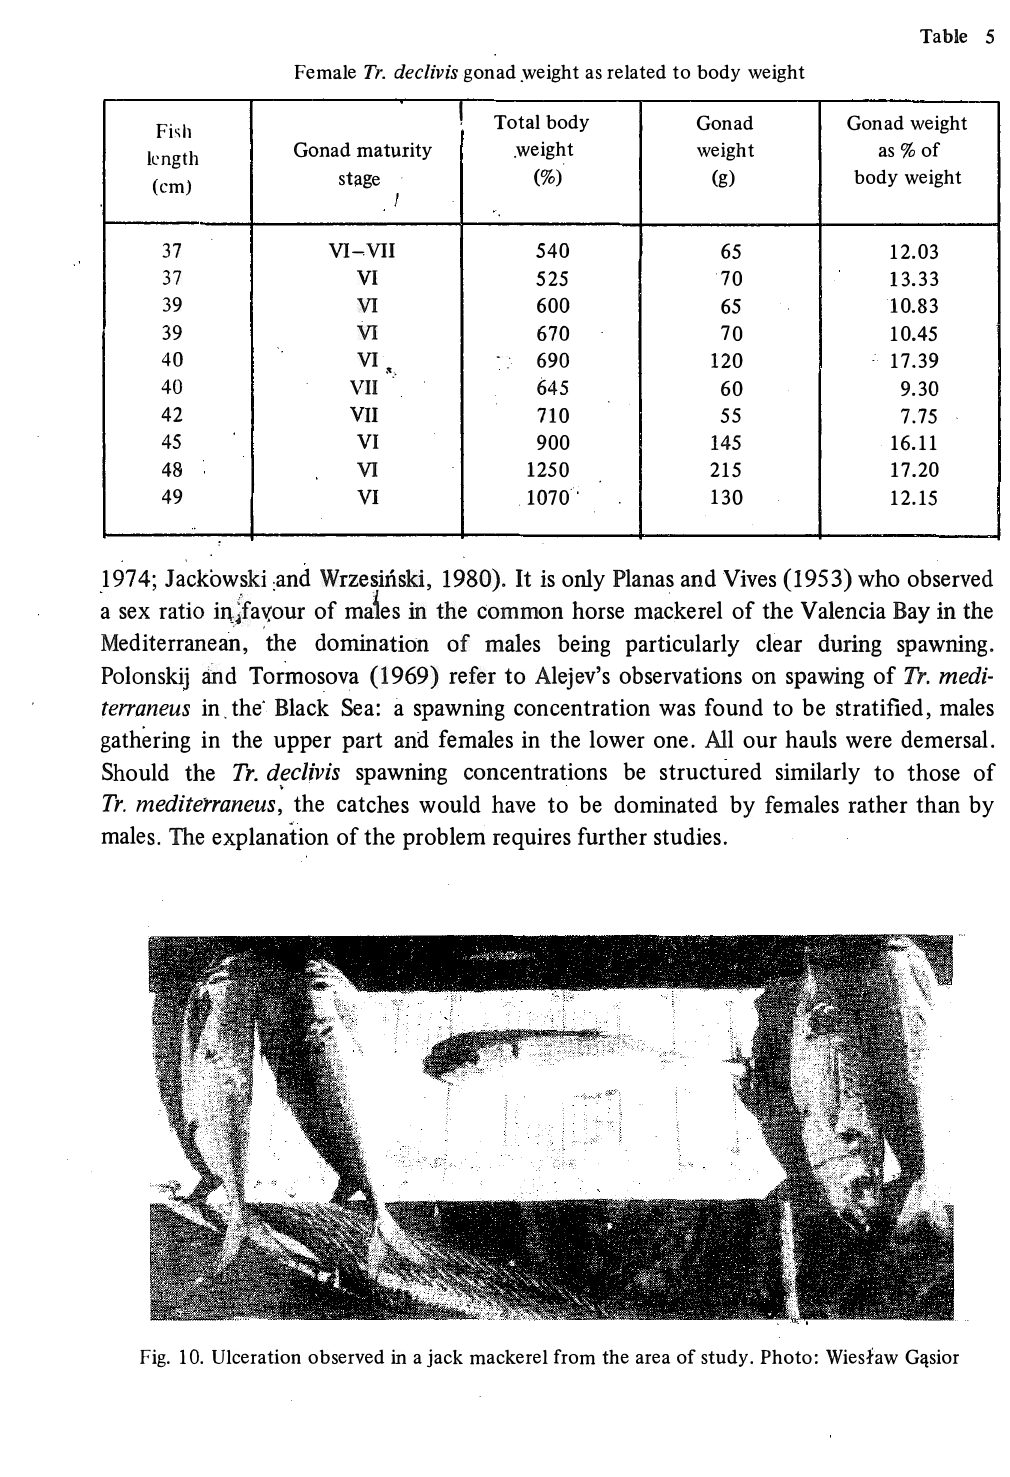
Female Tr. declivis gonad .weight as related to body weight ' Total body Gonad Gonad weight Fi,h length Gonad maturity .weight